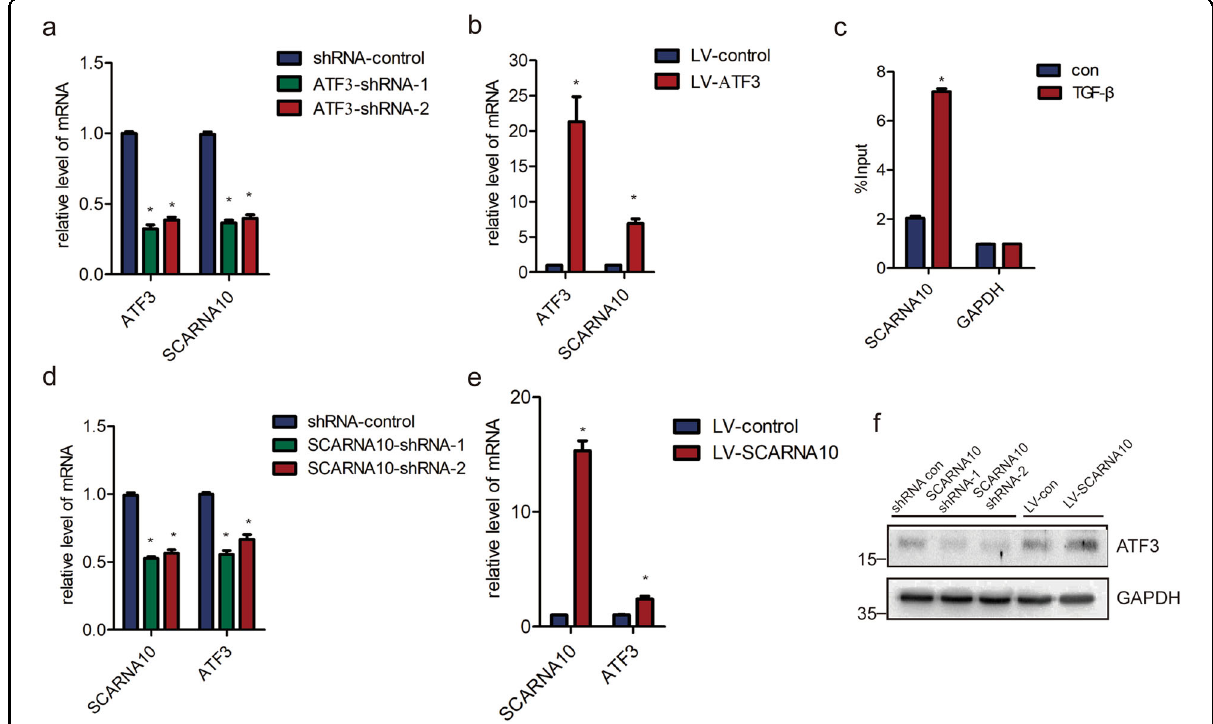
Fig. 6 lnc-SCARNA10 forms a positive feedback loop with ATF3. a LX-2 cells were infected with ATF3-shRNA1/2 for 72 h. The expression of lnc- SCARNA10 was detected by qRT-PCR. b The expression of lnc-SCARNA10 was detected in LX-2 cells infected with lenti-ATF3 or lenti-control by qRT- PCR. c LX-2 cells were treated with TGF- β and ChIP analyses were performed on SCARNA10 promoter regions, using anti-ATF3 antibody. Enrichment was shown relative to input. d – f LX-2 cells were infected with lnc-SCARNA10 shRNA1/2 or lenti-lnc-SCARNA10 for 72 h. The expression of ATF3 was detected by qRT-PCR and western blot. GAPDH was used as an internal control. The data were expressed as the mean ± SEM for at least triplicate experiments. GAPDH was used as an internal control; * p <